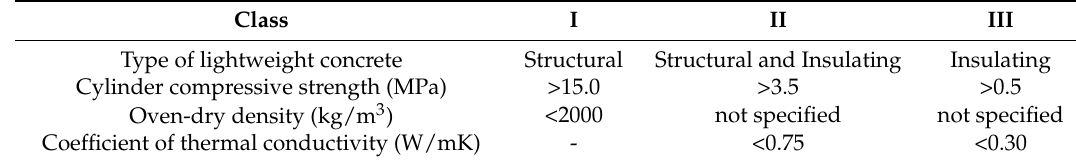
Table 4. Functional classification of LWAC (RILEM, 1978) [34].